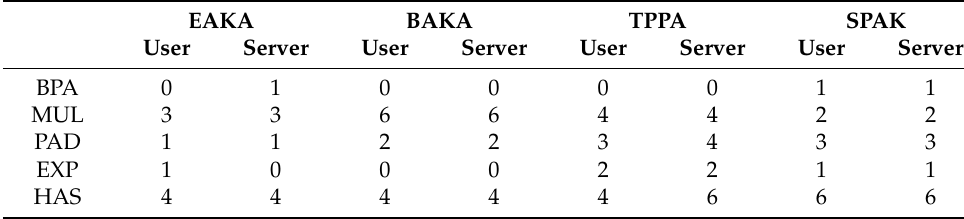
Table 4. Comparison of number of cryptography